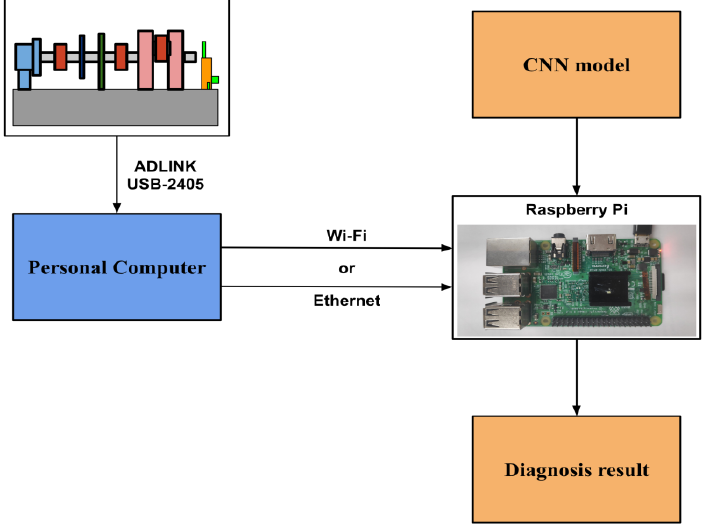
Figure 13. Schematic diagram of the diagnosis process.